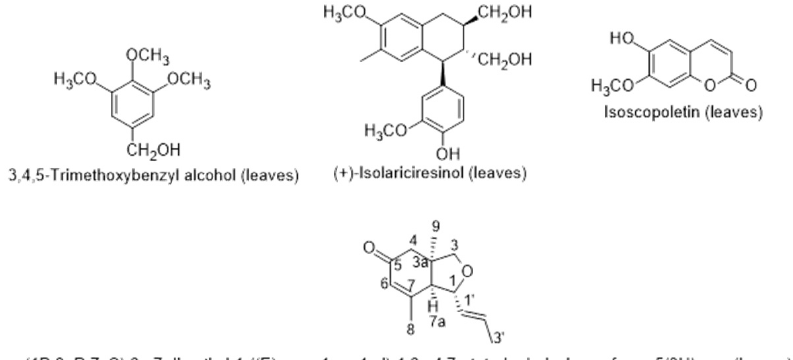
Figure 8. Metabolites found in leaf extracts of Lycium intricatum from Algeria [101].